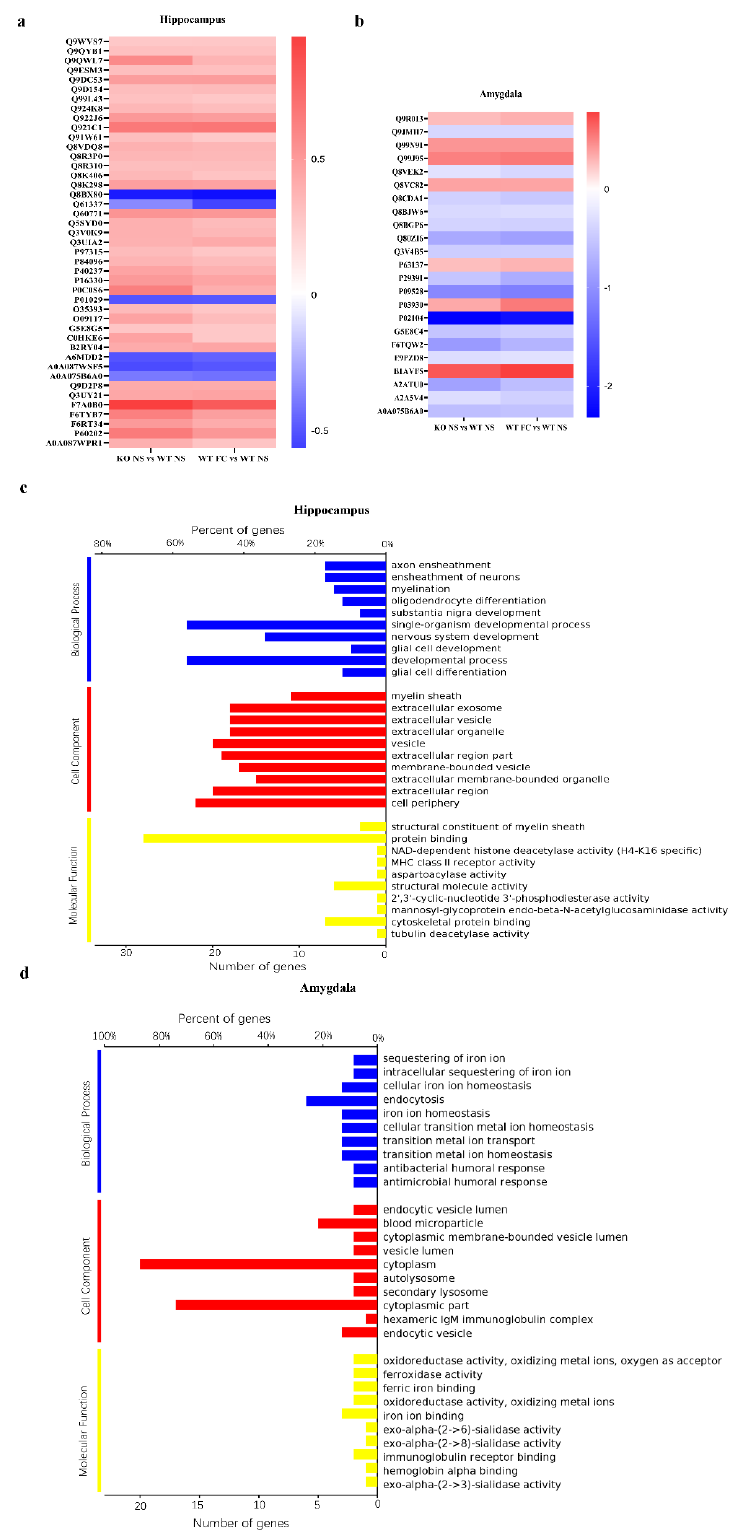
Figure 6. Common DEPs shared by the KO NS and WT FC mice and their GO analysis. Heatmaps of common DEPs shared by the KO NS and WT FC mice compared with the WT NS in the hippocampus ( a ) and amygdala ( b ). The Uniprot ID of these DEPs are provided on the left, and the rectangles with a gradient color from red to blue were for log2 fold change. The GO analysis of common DEPs shared by KO NS and WT FC compared with WT NS in the hippocampus ( c ) and amygdala ( d